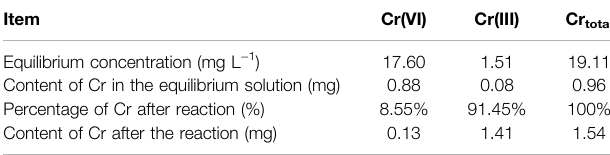
TABLE 1 | Removal Cr(VI) and suspended component by